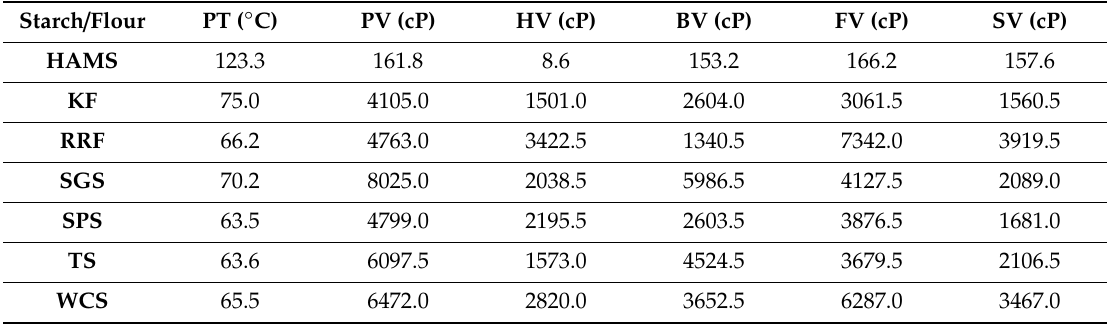
Table 4. The pasting properties of 10% w / w starch or flour suspension.